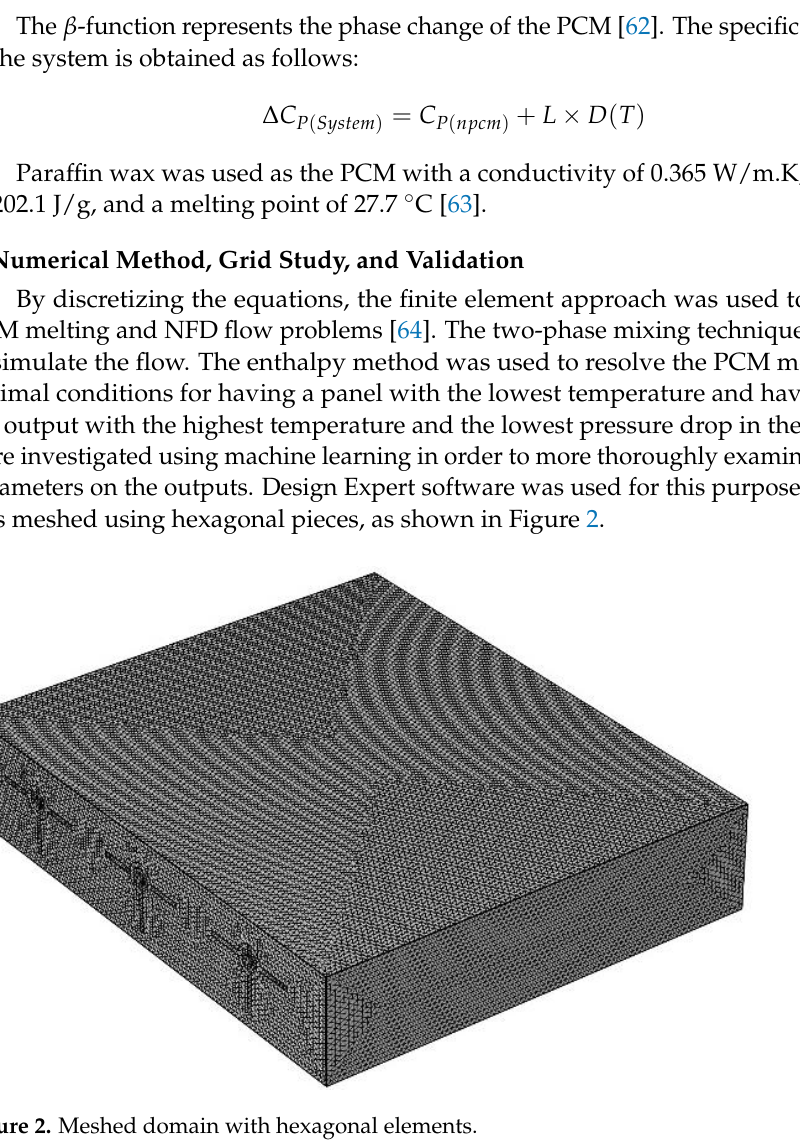
Table 2. Output flow temperature for a D_Pipe of 6